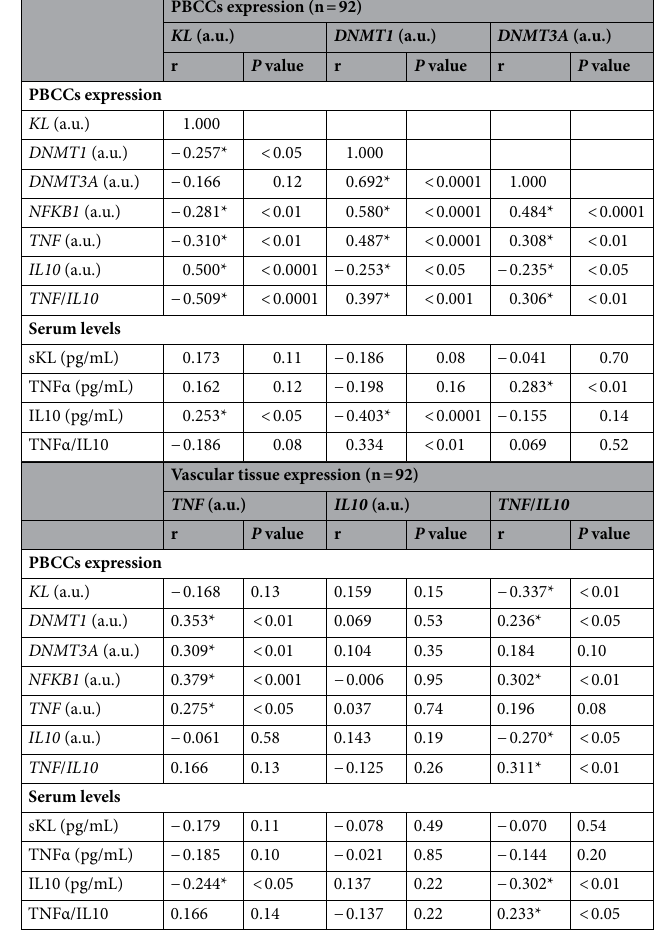
Table 2. Bivariate correlation analysis between PBCCs expression, vascular tissue expression and serum levels parameters.